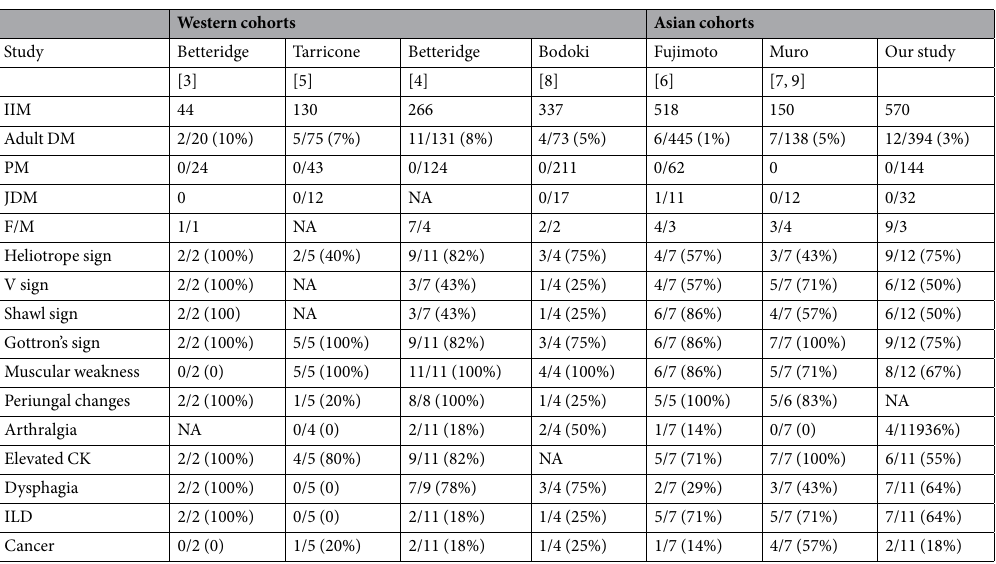
Table 3. Frequency of anti-SAE occurrence in different myositis